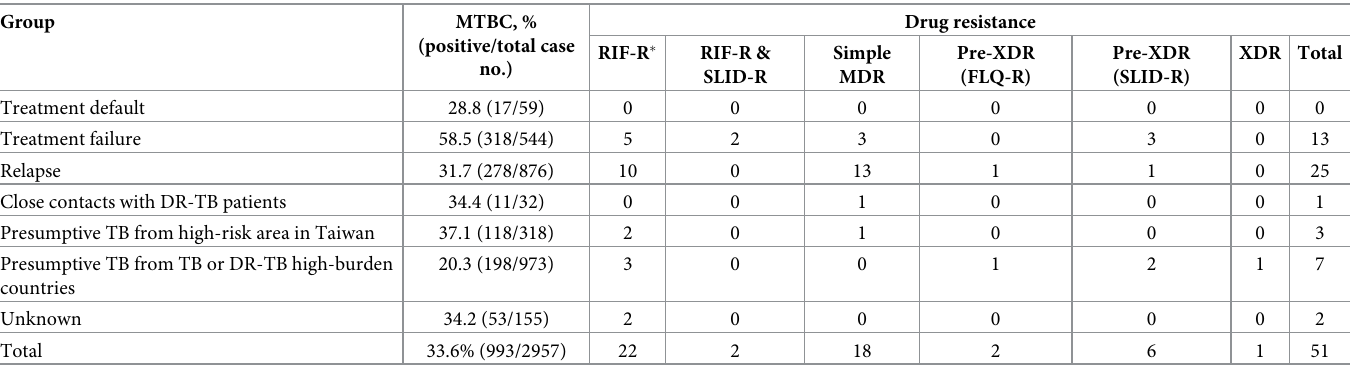
Table 1. Xpert and LPA results for high-risk DR populations.